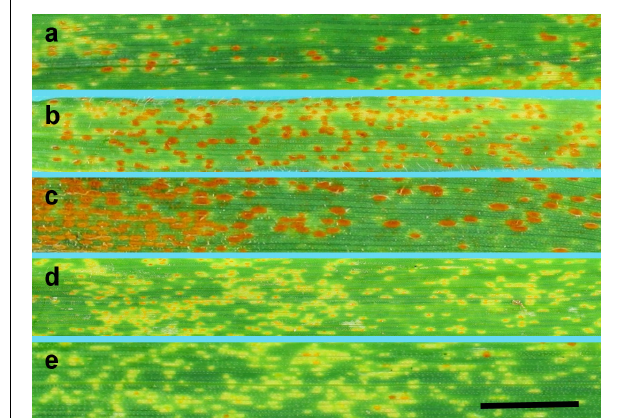
FIGURE 2 | Macroscopic observation of the infection rates (8 days) after inoculation of control plants with Pt11WT12 (isolate 4) at the adult plant stage (flag leaf). Wheat cv. Thatcher (rated as “3”) (a) , Ae . tauschii (rated as “3”) (b) , triticale cv. Bogo (rated as “4”) (c) , Tc + Lr22a (rated as “2”) (d) , Tc + Lr39 (rated as “1”) (e) . Scale bar 1